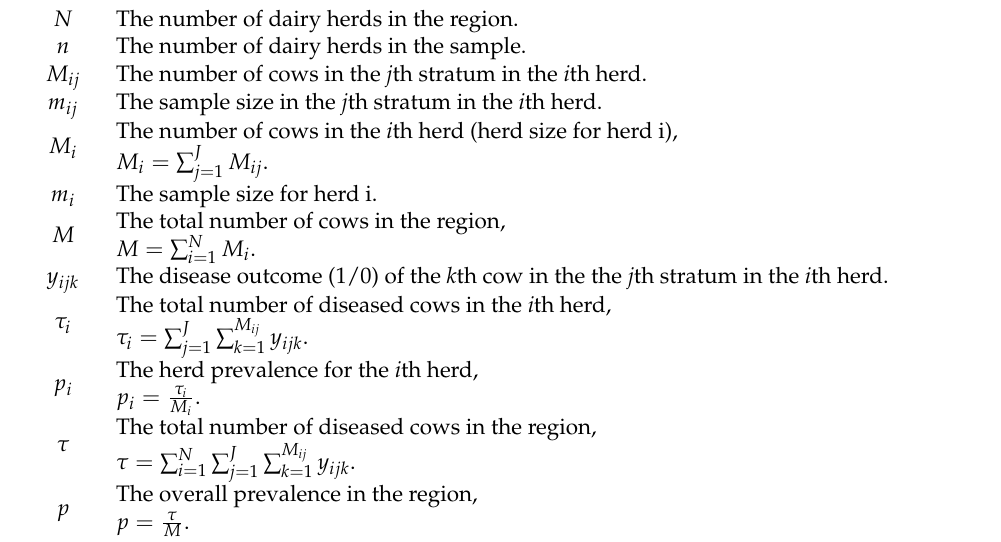
Table 1. Quantities used in a two-stage cluster sampling design, where stratified random sampling is implemented in the second